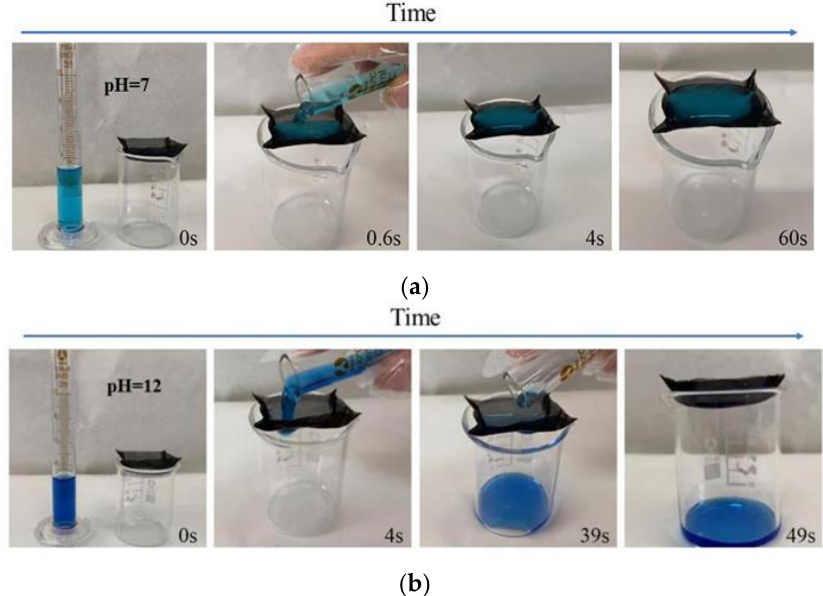
Figure 3. Illustrated images of the unidirectional water transportation. Acidic and neutral water were blocked by the rough mesh film ( a ); unidirectional penetration occurred when the pH of the water was increased to 12 ( b ). Water was dyed blue by methylthionine chloride.